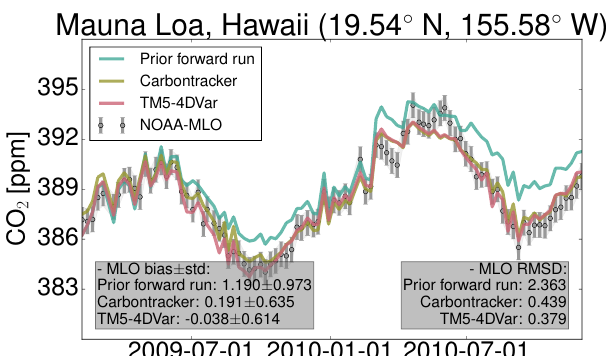
Figure 1. Time series of measured and modeled CO 2 concentra- tions from CarbonTracker and TM5-4DVar at Mauna Loa, Hawaii (assimilated weekly flasks), NOAA site code MLO. Also shown are the concentrations obtained from a forward run of the transport model using the a priori background flux